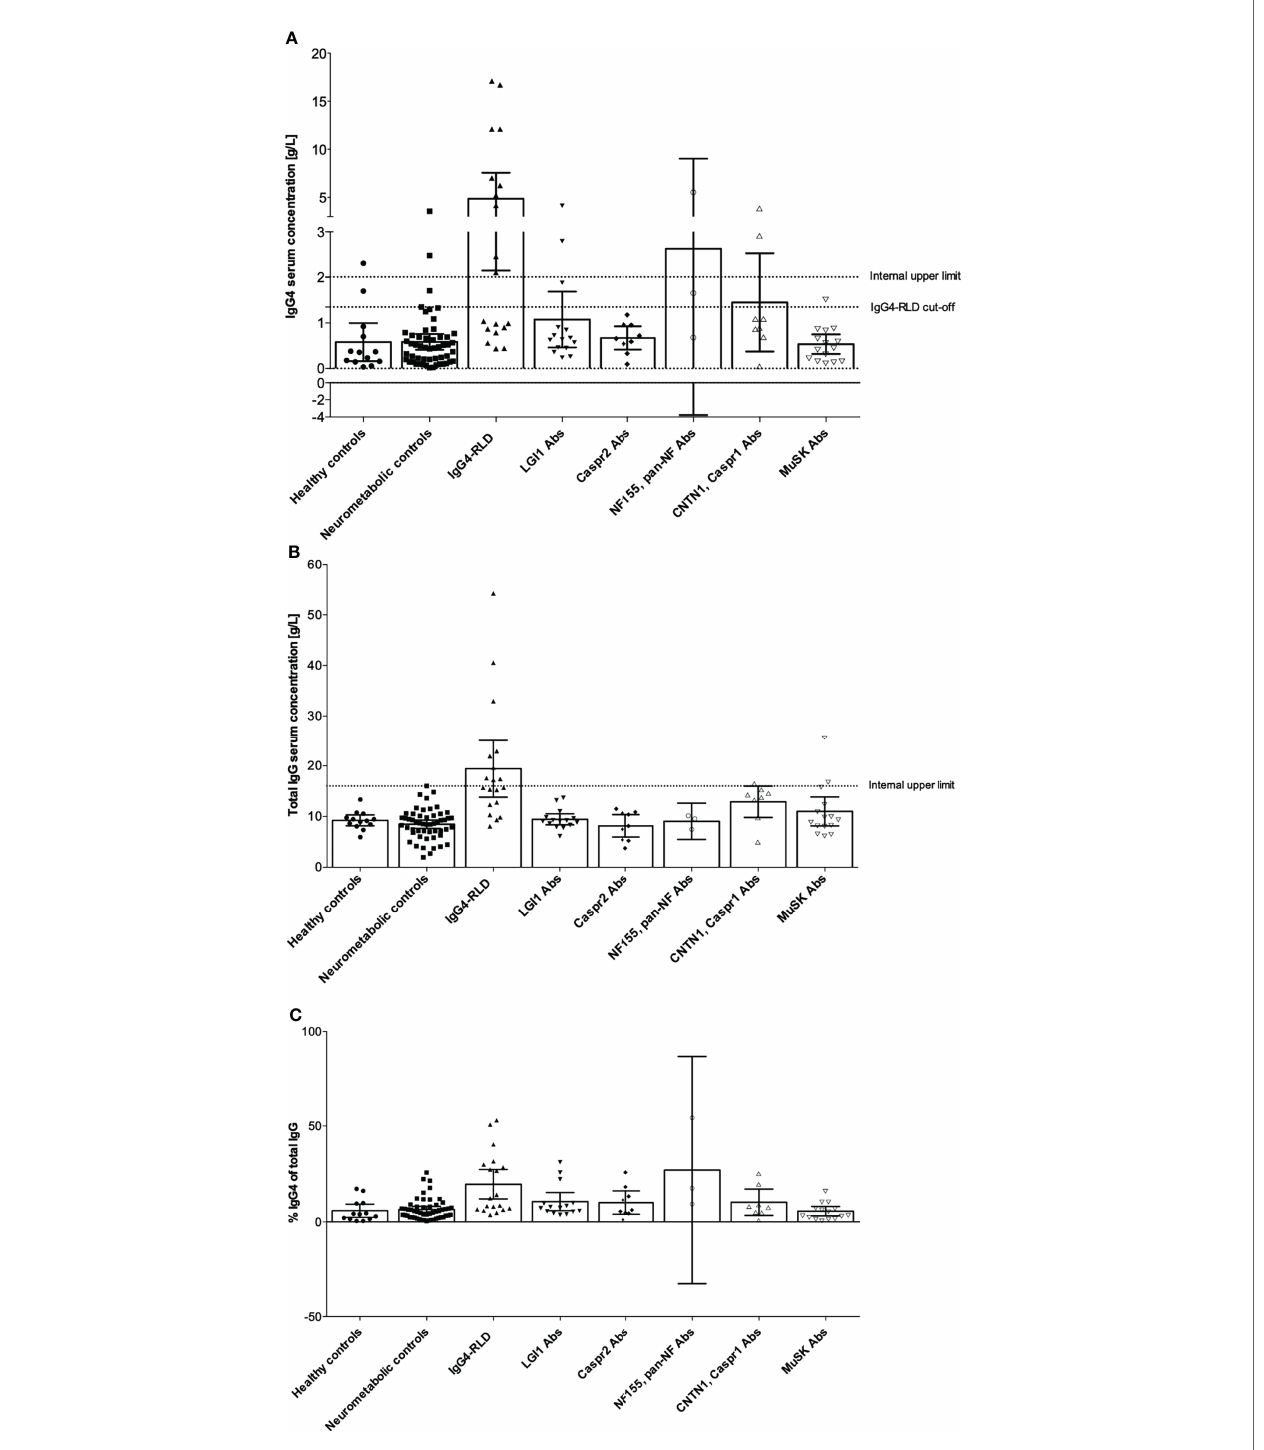
FIGURE 2 | Serum IgG4 and total IgG concentrations in patients with IgG4 autoantibodies, IgG4-RLD, neurometabolic and healthy controls. IgG4 concentrations were obtained by nephelometry. (A) Serum IgG4 concentrations. The internal upper limit for IgG4 concentrations is indicated as a line at 2.01 g/L, the of fi cial cut-off for elevated IgG4 concentrations in IgG4-RLD is indicated as a line at 1.35 g/L. (B) Total serum IgG concentrations. The internal upper limit for total IgG is indicated as a line at 16 g/L. (C) Percent IgG4 of total IgG. Bar graphs indicate mean and error bars indicate 95% CI. Abs, antibodies; Caspr1, contactin-associated protein- like 1; Caspr2, contactin-associated protein-like 2; CNTN1, contactin 1; IgG, immunoglobulin type G; IgG4, immunoglobulin type G subclass 4; IgG4-RLD, IgG4- related disease; LGI1, leucine-rich glioma inactivated protein- 1; MuSK, muscle-speci fi c kinase; NF155, neurofascin